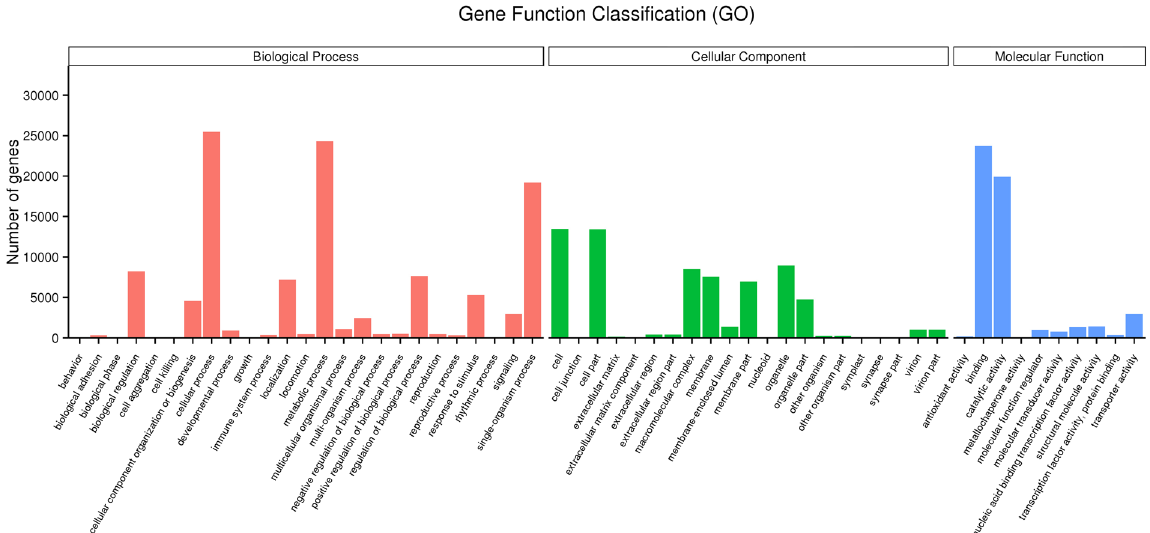
Figure 4. GO categorization of non-redundant unigenes.